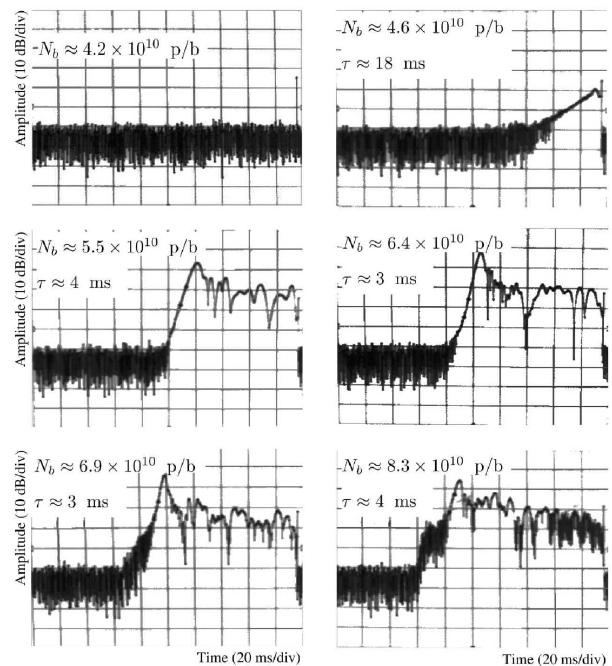
FIG. 25. Time evolution of the first unstable betatron line during electron-cloud experiments at the CERN PS in 2001 [36]; the LHC bunches are shortened and stored at a constant length for the last 100 ms; the horizontal axis is time with 20 ms per division; the various pictures refer to different bunch pop- ulations, increasing from 4 : 2 (cid:1) 10 10 to 8 : 3 (cid:1) 10 10 ; the signal was obtained by a spectrum analyzer with zero span and central frequency set to 357 kHz.